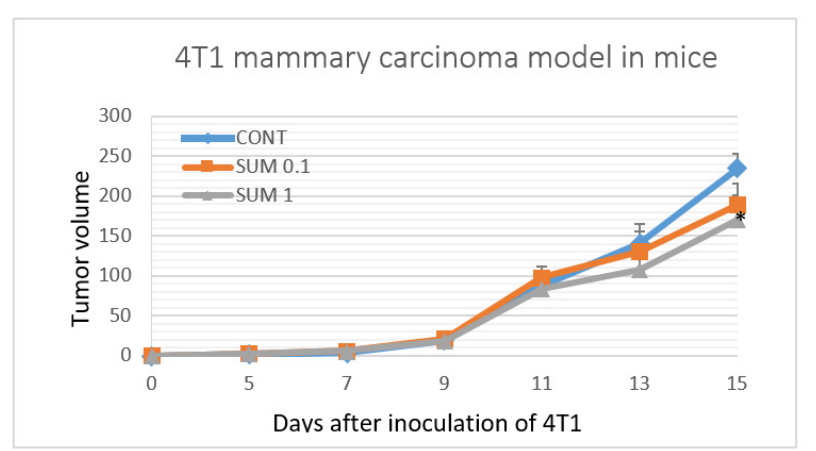
Figure 2. CONT—control group, SUM 0.1—group with administered sumac at a concentration of 1 g/kg in diet, SUM 1—group with administered sumac at a concentration of 10 g/kg in diet. The development of the volume of 4T1 mammary adenocarcinomas in mice allograft model during the experiment. Data are expressed as mean ± SEM. Significant differences: * p < 0.05 vs. CONT. Table 1. Histopathological characteristics of 4T1 tumors in Balb/c mice after R. coriaria treatment. Parameter